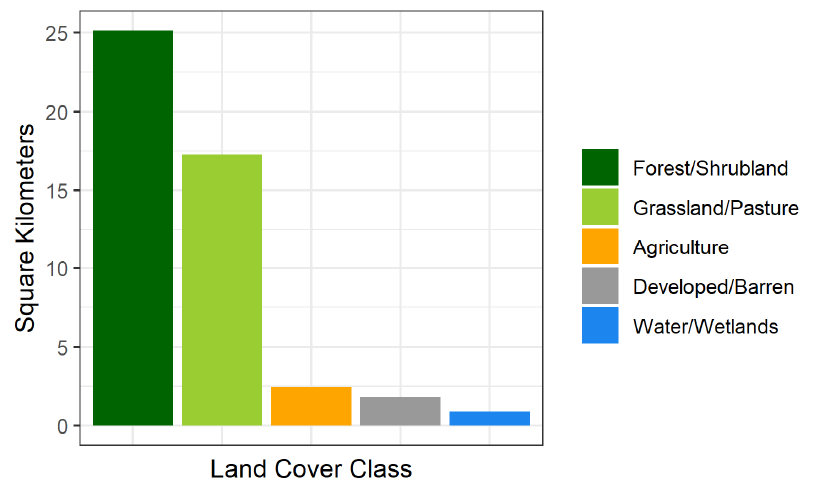
Figure 4. Area of relatively higher suitability cropland predicted by the Storie index, grouped by landcover according to the 2020 Cropland Data Layer. For the purposes of this analysis, high suitability is defined as areas ranking “good” or “very good” in the Storie index.